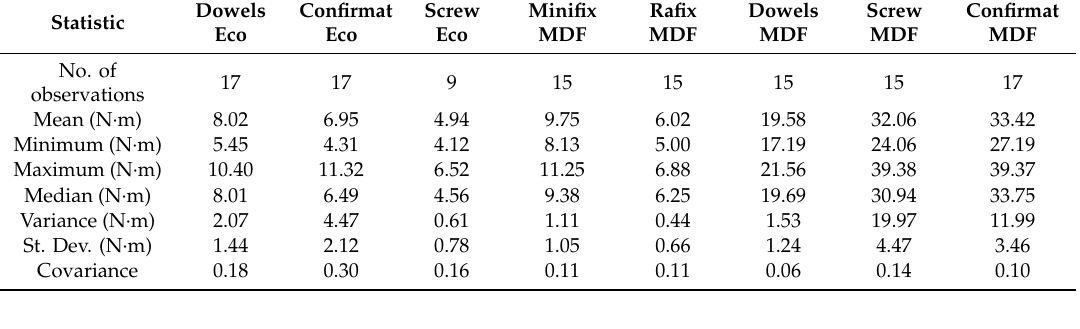
Table 2. Descriptive statistics for the bending strength capacity of L-type corner joints constructed from eco-friendly composites (Eco) and MDF.